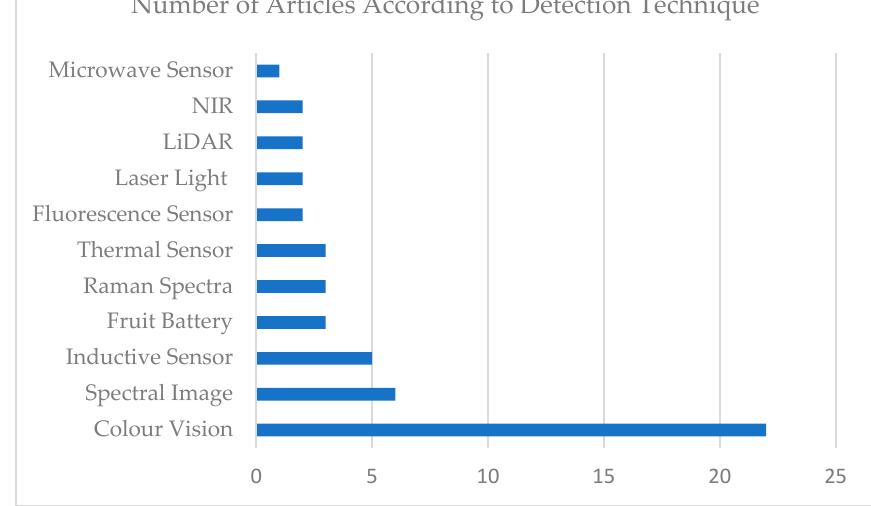
Figure 1. The number of articles reviewed based on different detection methods.